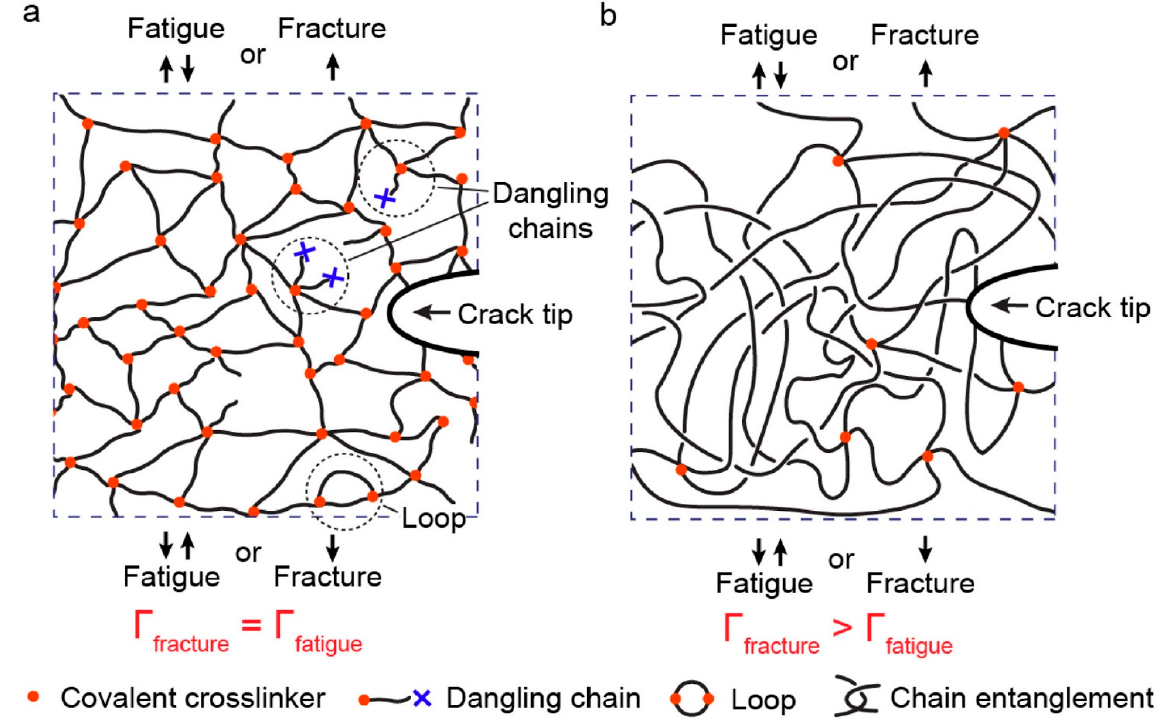
Figure 32. Fracture and fatigue of ( a ) entangled and ( b ) unentangled polymer networks under cyclic loading, adapted with permission from Ref. [110]. Copyright © 2022 Elsevier